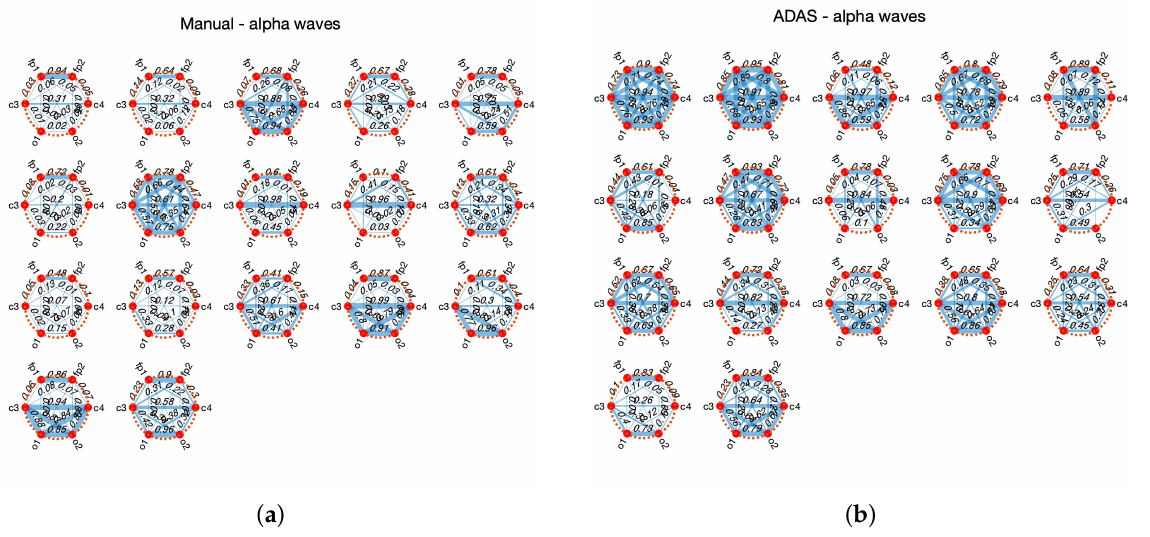
Figure 3. Connectivity networks of subjects 1–17. The thicker lines are associated with higher correlation. ( a ) Manual, alfa waves; ( b ) ADAS, alpha